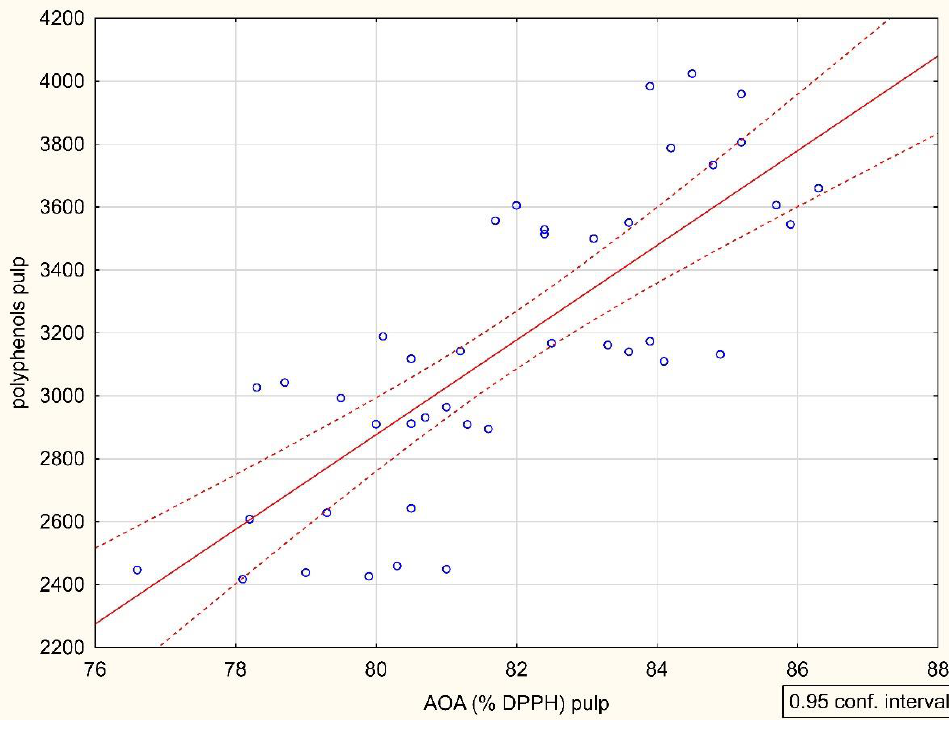
Figure 4. The correlation of AOA and TPC in okra pulp.